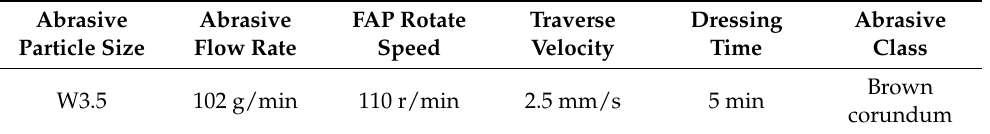
Table 4. Process parameters of the jet